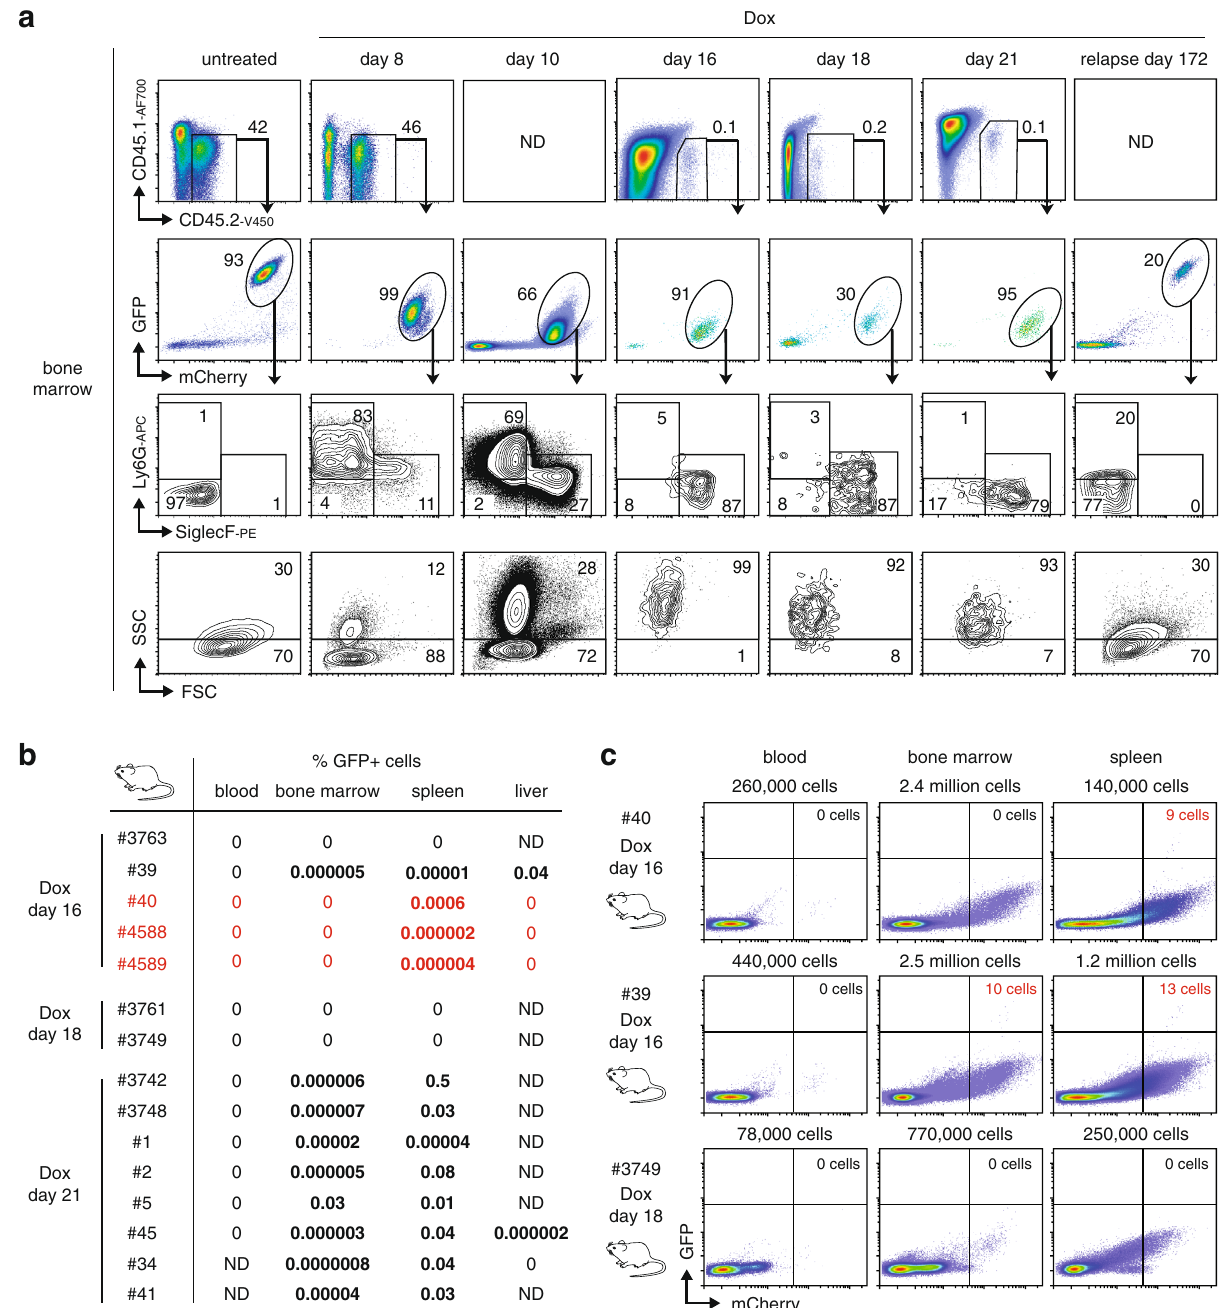
Fig. 4 Analysis of early leukemia relapse in vivo. a Flow cytometry analysis of AML-derived (mCherry + ) cells from representative mice harvested at various Dox treatment timepoints and at relapse. ND, not determined (host mouse was CD45.2 + ). b Summary of the distribution of mCherry + GFP + early relapse cells detected in mice following the indicated Dox treatments. Mice with extramedullary relapse are shown in red. ND not determined. c Flow cytometry of blood, bone marrow, and spleen detecting organ-speci fi c GFP + leukemia relapse (red labeled quadrant) in representative AML246-Cherry leukemic mice following 16 – 18 days Dox treatment. The GFP threshold is set high to avoid the mCherry “ smear ” associated with leukemia cell death and host-mediated clearance, and to identify genuine GFP HIGH early